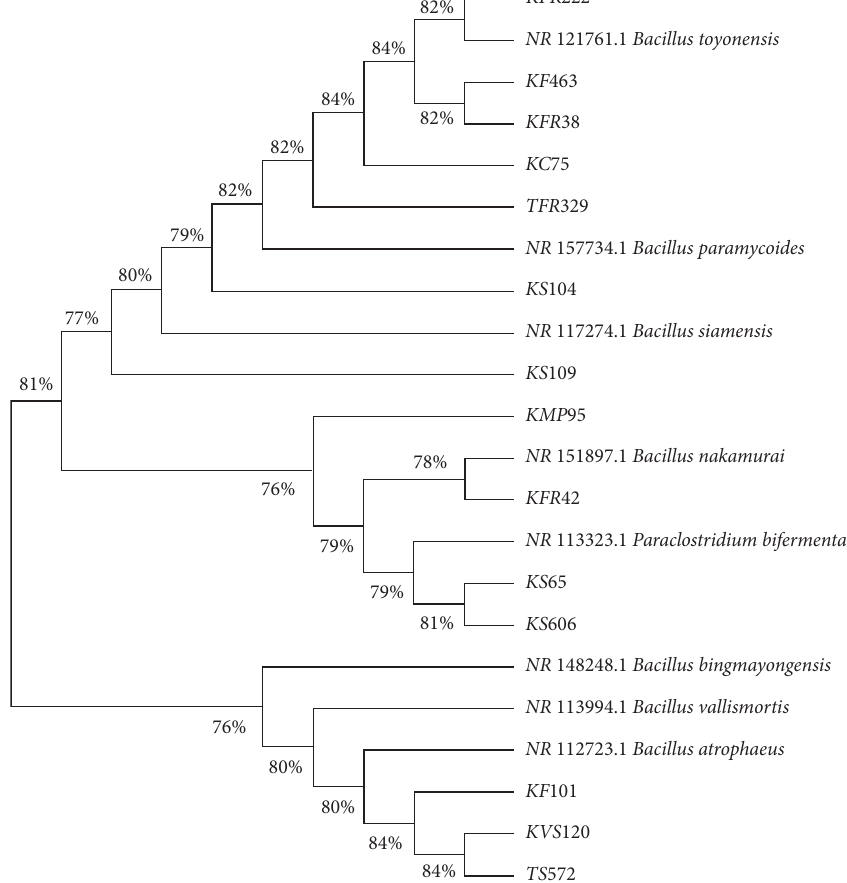
Figure 6: Phylogenetic relationships of bacterial isolates from vended food and soil in Embu Town and Kangaru Market. The evolutionary history was inferred through the neighbor-joining method. Isolates from the present study are presented in the phylogenetic tree using the isolate number